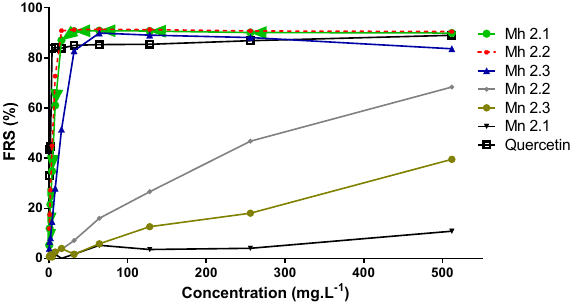
Figure 1. DPPH radical scavenging activity of the extracts of M. nobilis and M. hernandoi . Values are expressed as percentage DPPH radical scavenged.